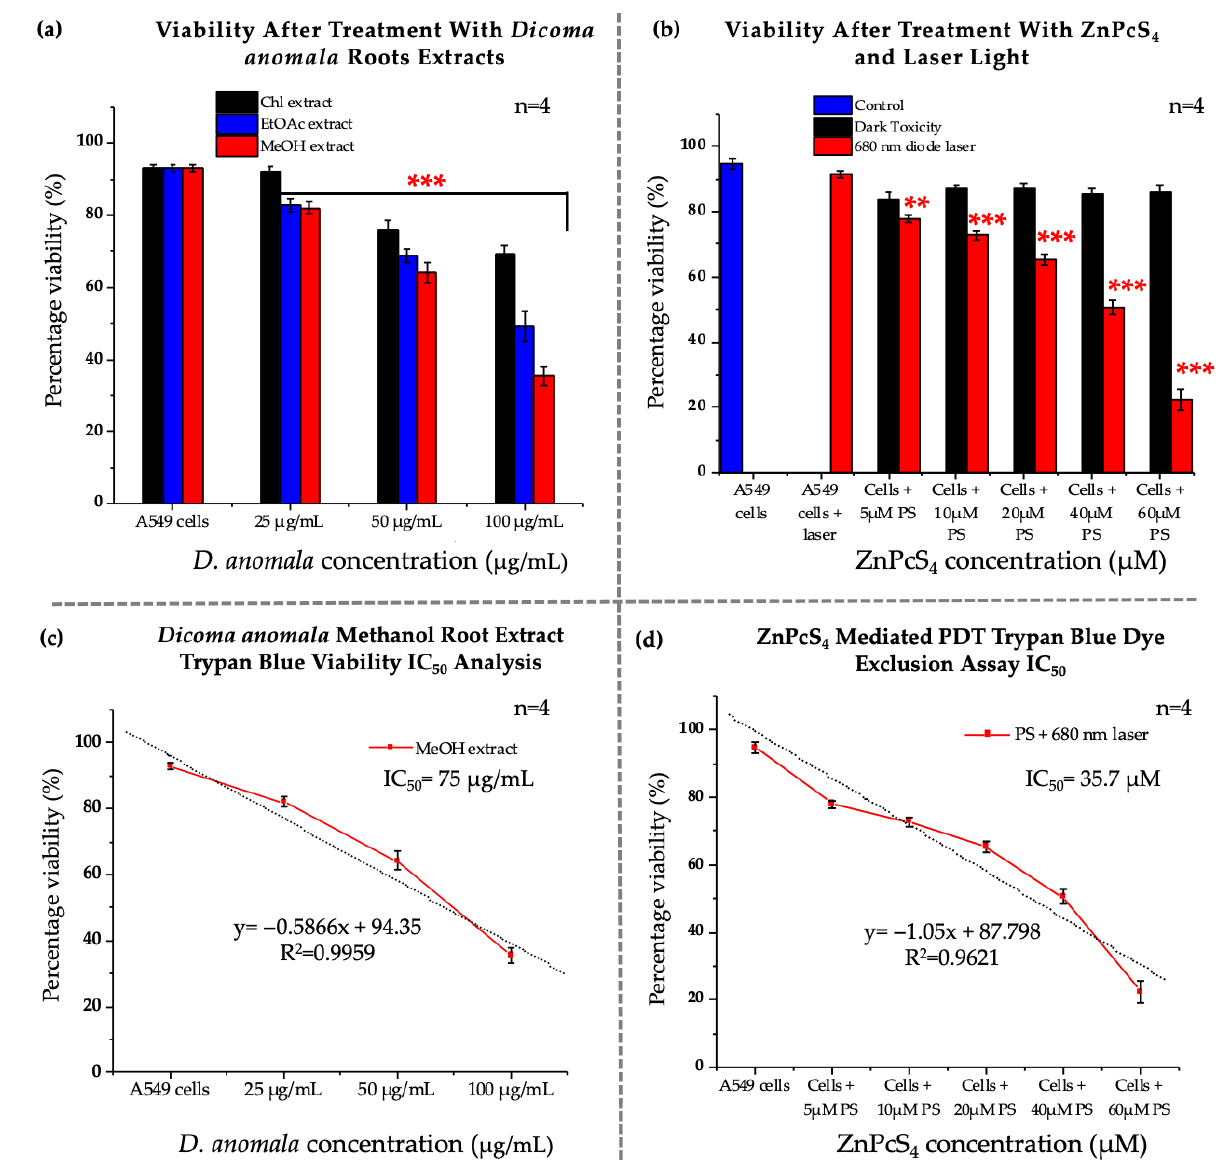
Figure 4. Trypan blue viability of A549 cells post-treatment with D.A (Chl, EtOAc, and MeOH) ( a ), and ZnPcS 4 ( b ). D.A MeOH root extract IC 50 ( c ), and ZnPcS 4- mediated PDT IC 50 ( d ). The values depicted in ( a , b ) are mean ± standard errors. Significant mean differences of independent treatments are represented as ** p < 0.01, and *** p < 0.001.